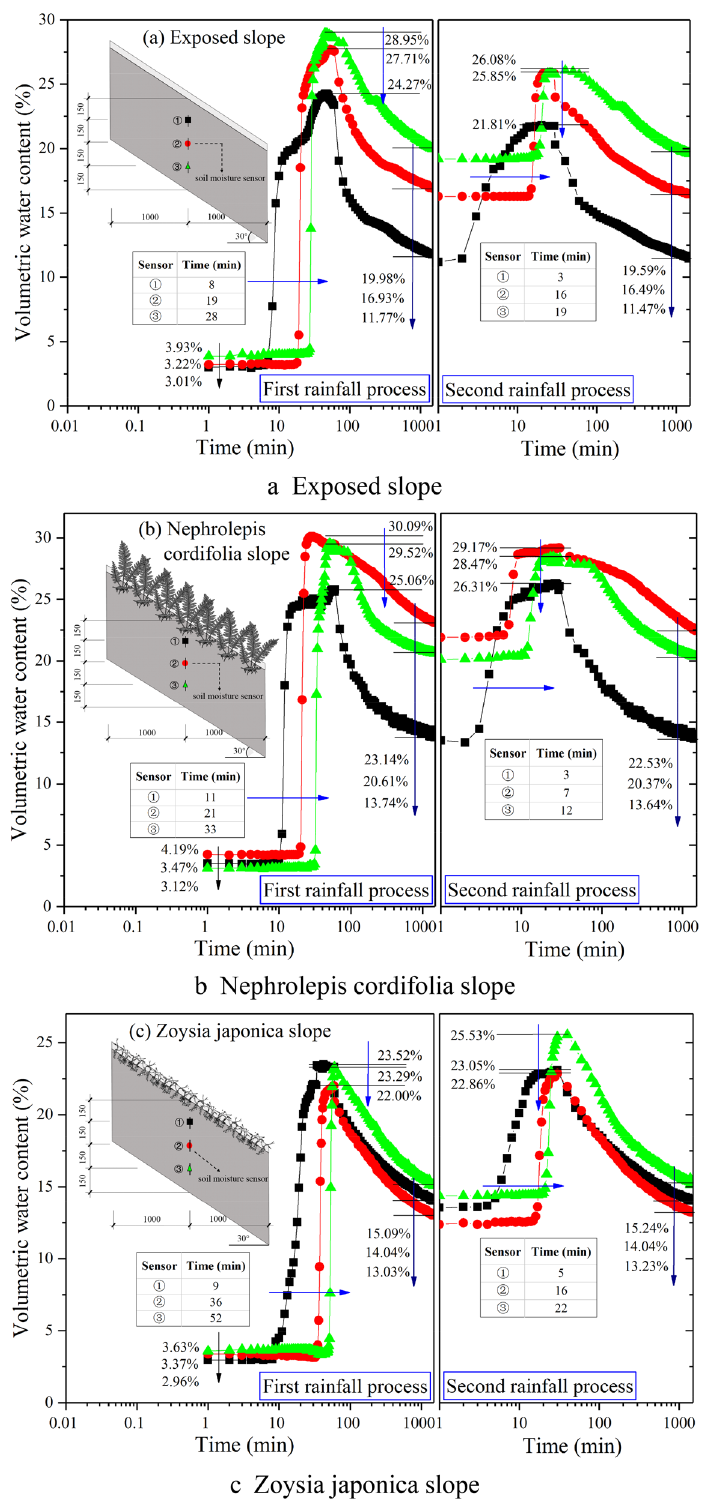
Figure 4. Variation law of the soil moisture content at sensor locations ① – ③ on each